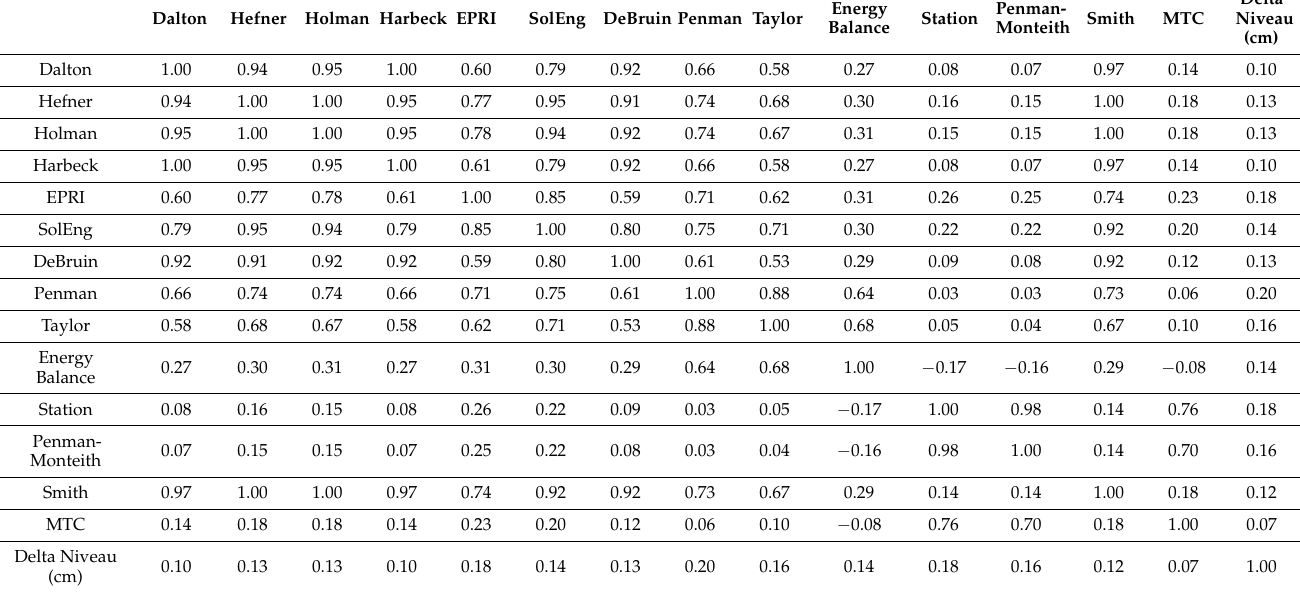
Table 3. Correlation matrix of evaporation rates estimated using the different methods for the year 2018 at Thomas